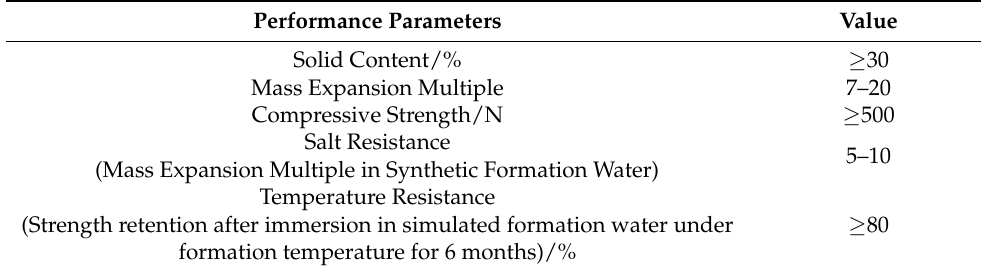
Table 16. Performance evaluation data of SP.